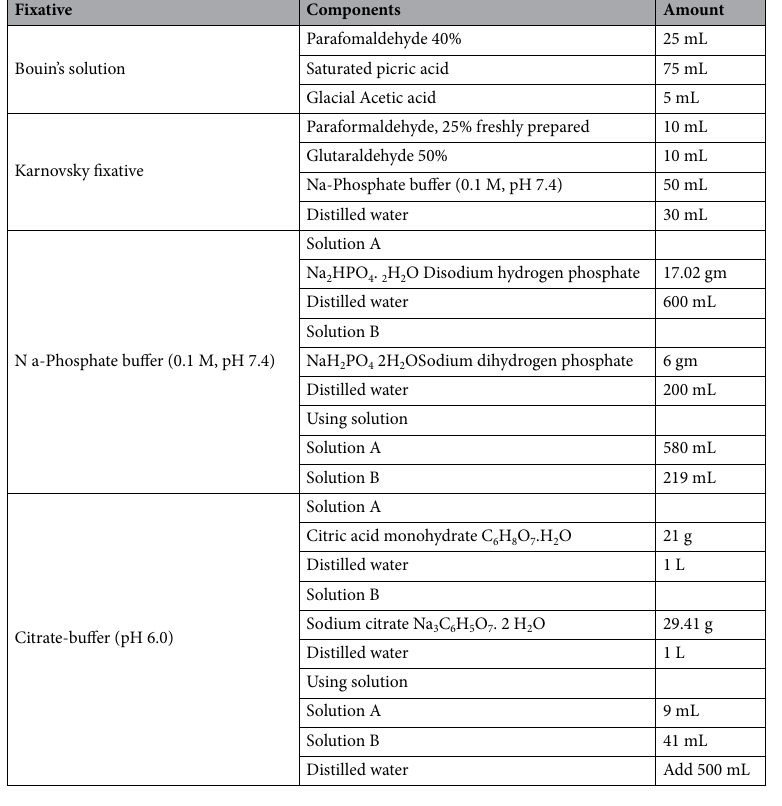
Table 1. Components of the